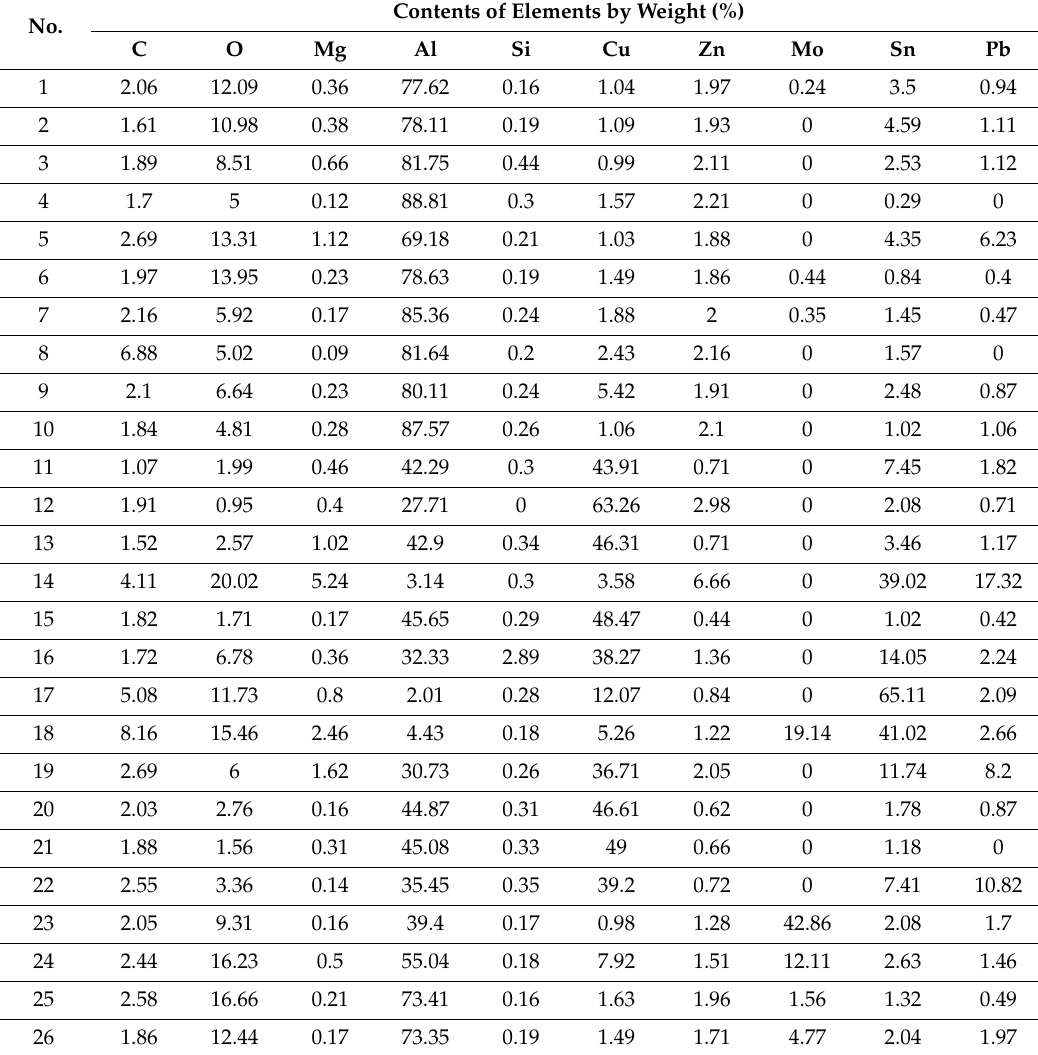
Table 5. EDS chemical identification of elements and their concentration in M3